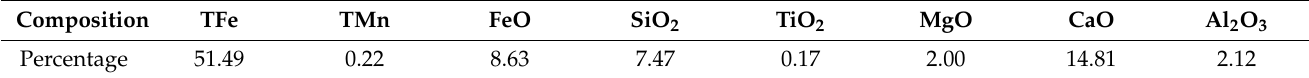
Table 2. Chemical composition of sinter (wt%).